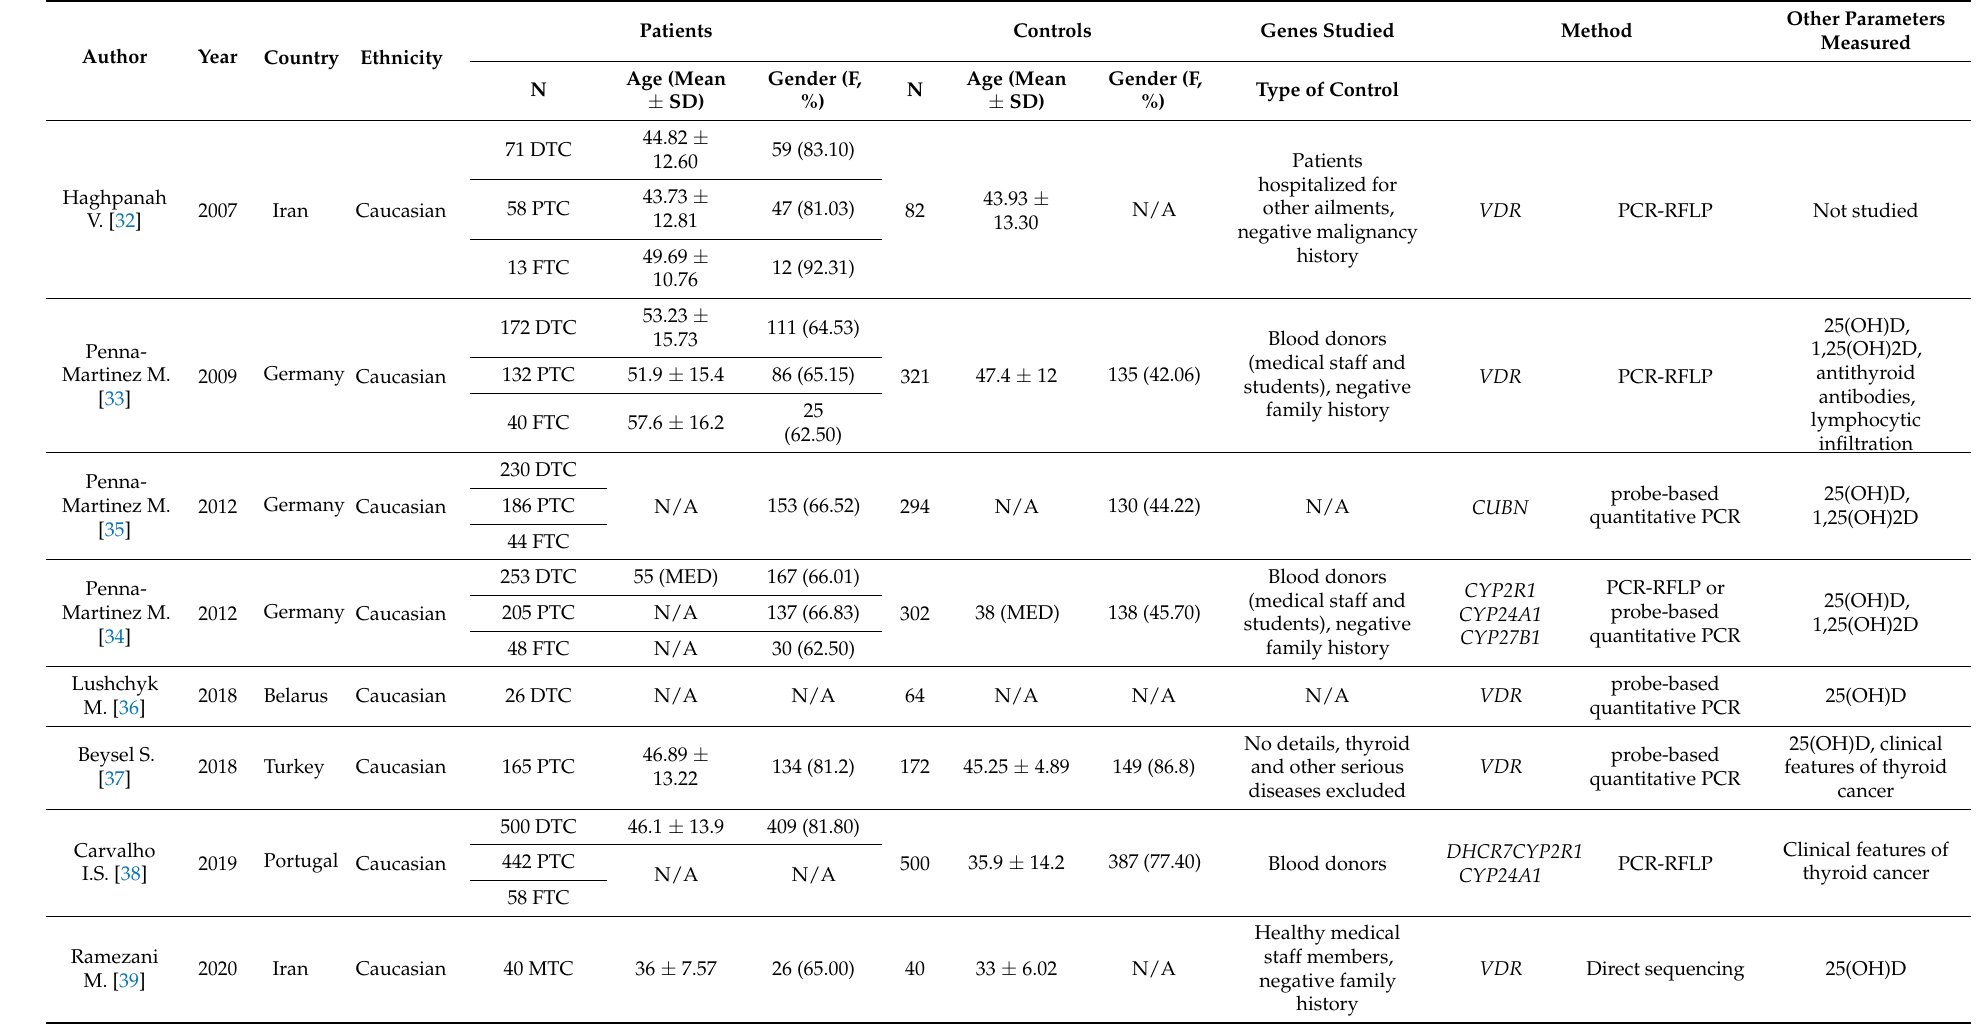
Table 1. Characteristics of the studies